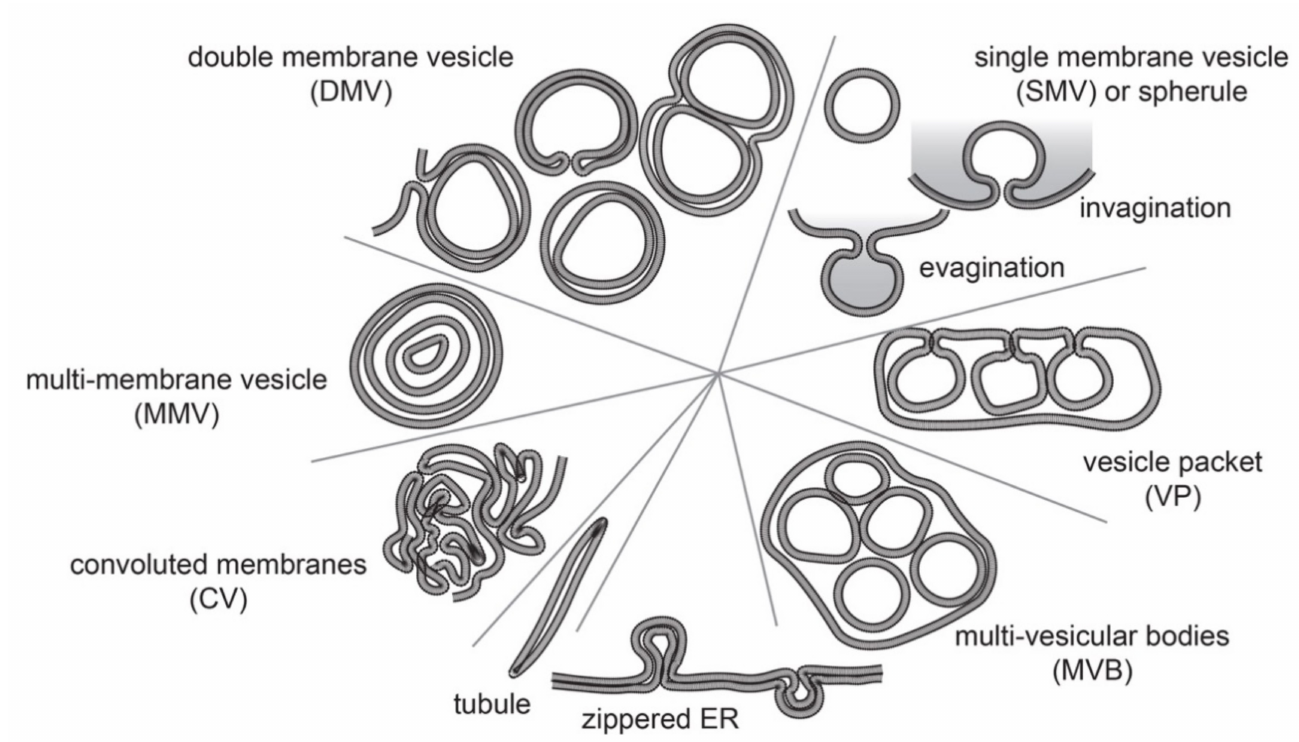
Figure 1. Membranous structures that occur in cell infected with positive-strand RNA viruses. Depicted are the most common membranous